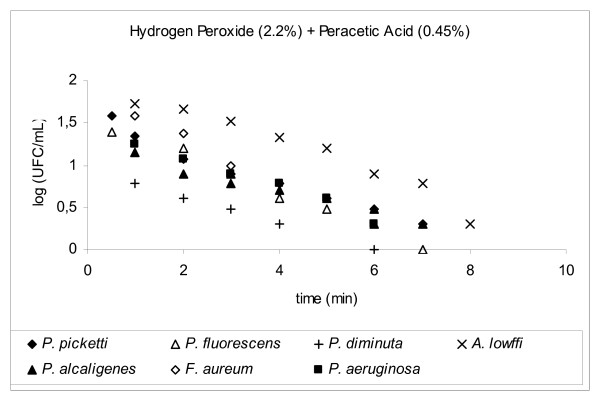
Graphic representation of the standard and in house microorganism reduction against different sanitizers.